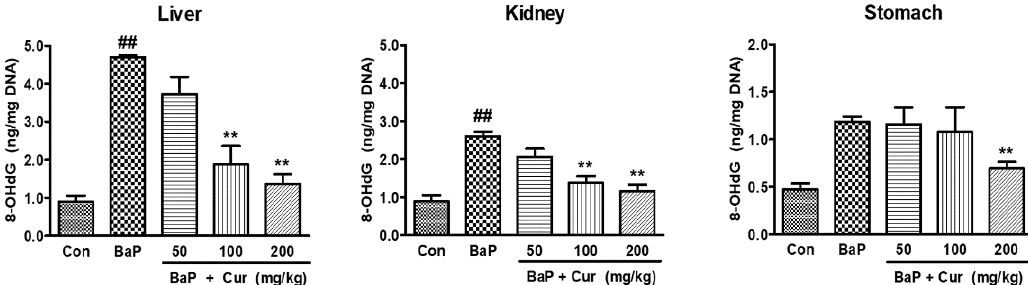
Figure 7. Effect of curcumin on the 8-hydroxydeoxyguanosine (8-OHdG) formation in the target organs of Sprague-Dawley rats treated with benzo[a]pyrene (BaP) . Rats were orally administrated BaP alone (20 mg/kg) or in combination with curcumin (50, 100, or 200 mg/kg) for 30 days. The control group was administered vehicle only. Values are indicated with mean ± SD of six animals. Significant difference from the control group at ## p < 0.01; Significant difference from the BaP alone group at ** p < 0.01. Cur: curcumin.